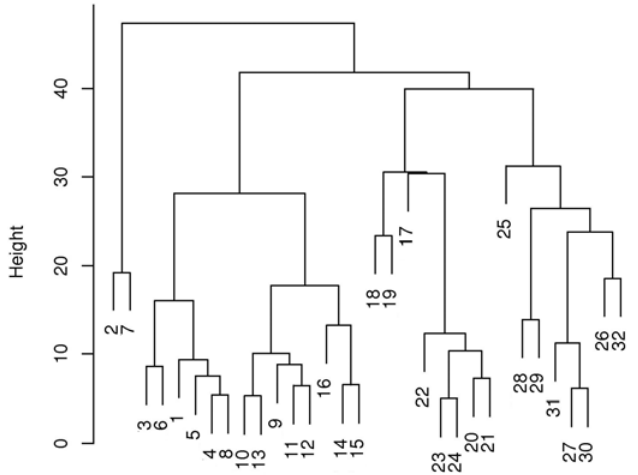
Figure 9. The dendrogram obtained using Minkowski distance for ATR-FT-IR spectra of 32 analyzed AChE